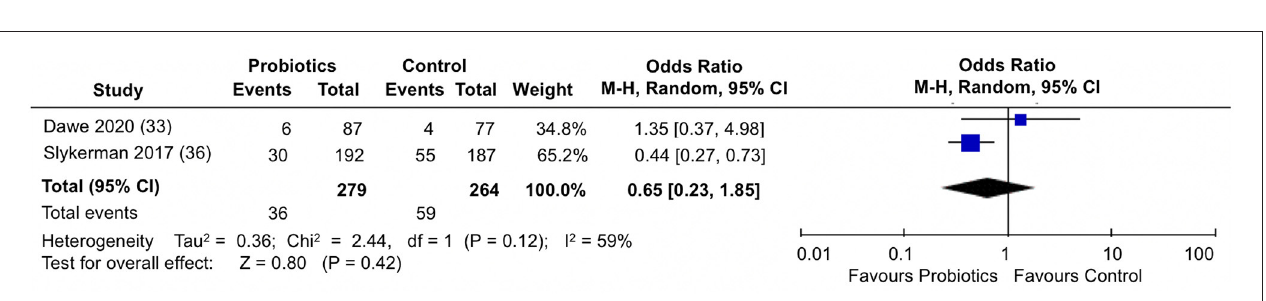
FIGURE 7 | Meta-analysis of the effect of probiotic supplementation on the proportion of participants scoring above cut-off in STAI-6 anxiety scores in the perinatal period.